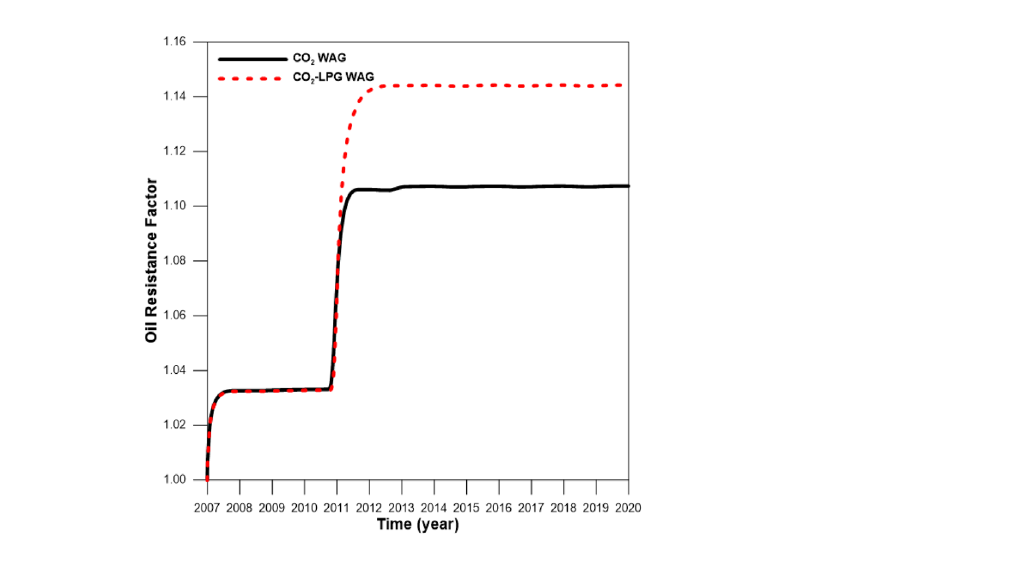
Figure 7. Oil resistance factor during CO 2 and CO 2 -LPG WAG